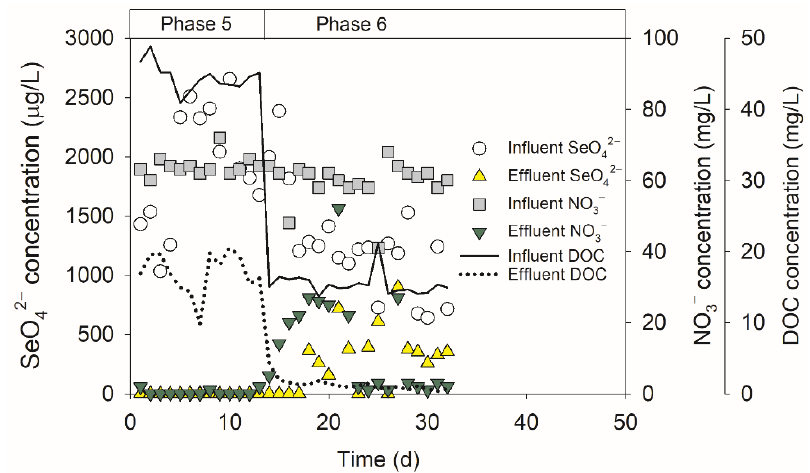
Figure 3. Effluent selenate and nitrate profiles in the FBBR reactor. The C:N mass ratio was controlled, changing from 3.3:1 (phase 5) to 1.3:1 (phase 6).